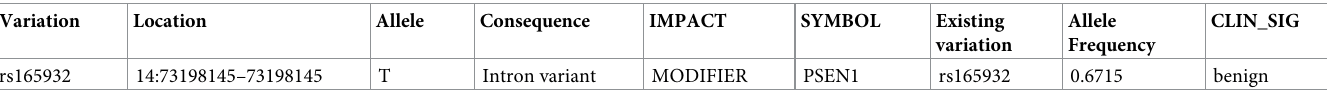
Allele CLIN_SIG variation Frequency